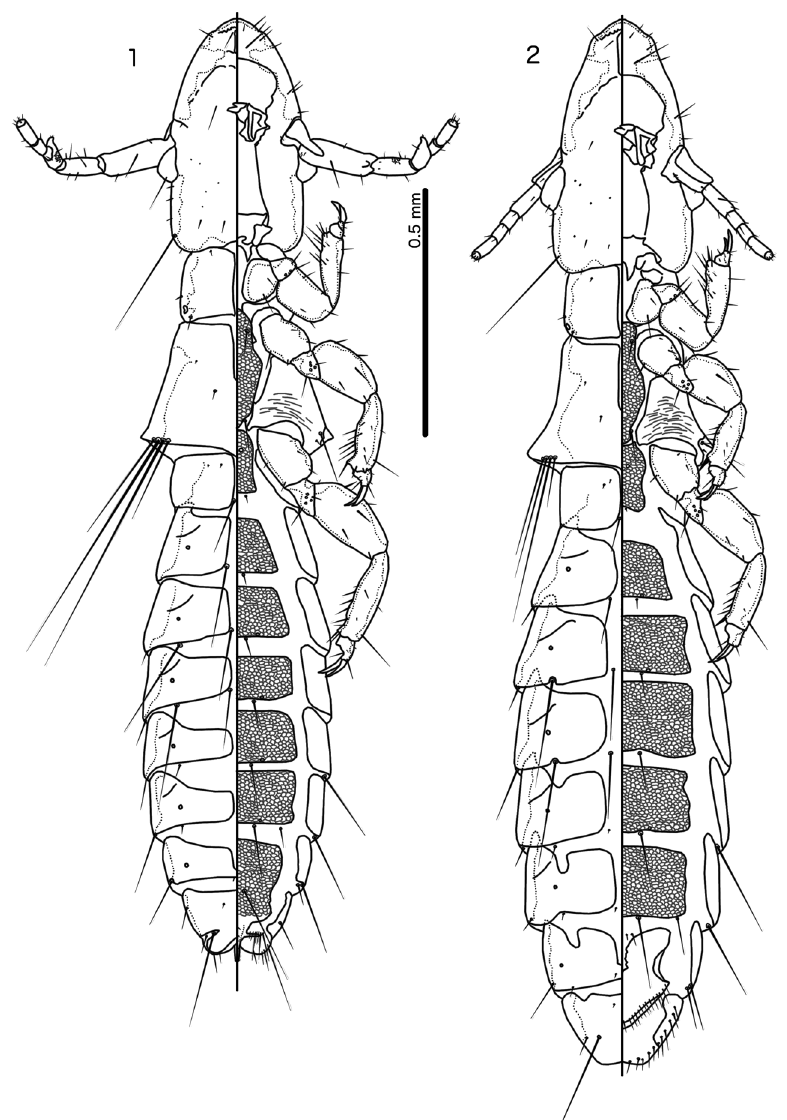
Figs 1–2. Calidolipeurus megalops (Piaget, 1880) gen. et comb. nov., based on specimens on slide NHMUK010682491 (NHMUK). 1 . Habitus, ♂, dorsal and ventral views. 2 . Habitus, ♀, dorsal and ventral